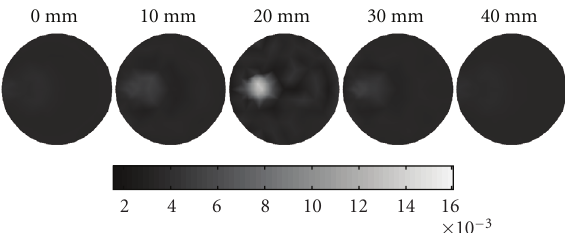
Figure 10: Reconstructed images using the proposed algorithm, which are 2D cross sections through the reconstructed 3D volume. The right-hand side corresponds to the top of the cylinder ( z = 40mm), whereas the left corresponds to the bottom of the cylinder ( z = 0mm), with each slice representing a 10mm